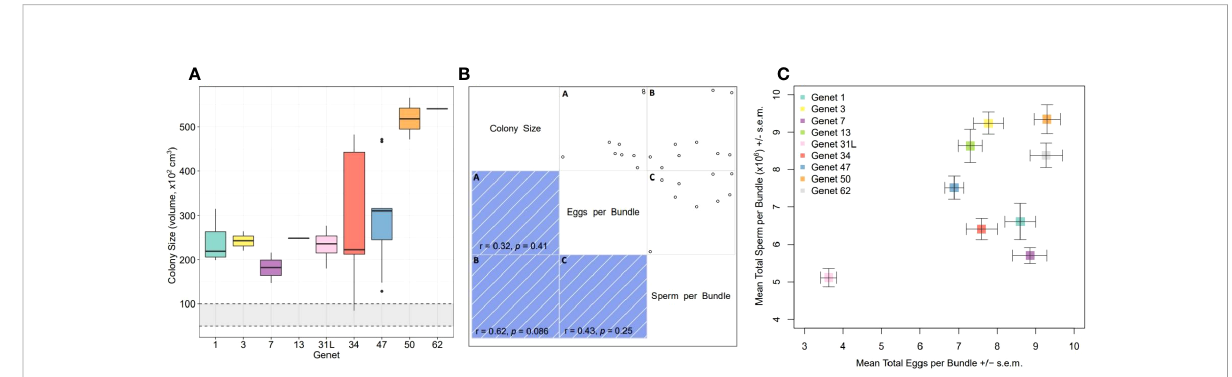
FIGURE 4 Gamete bundle fecundity analysis for nine A. cervicornis genets. (A) Colony size of the parents that the gamete bundles were collected from did not signi fi cantly differ across genets (statistics in text). The gray shaded region within the black dashed lines represents the estimated puberty size predicted for this species. Genet 31L refers to the colonies that came from a different nursery and which represent different colonies used in the fragment fecundity analysis (see methods). (B) Correlogram (correlation matrix) displaying the relationship between each pair of numeric variables as part of the gamete bundle fecundity analysis including mean colony size, mean total eggs per bundle, and mean total sperm per bundle. Scatterplots for each pair of variables is mirrored by visualization of the correlation coef fi cient including the direction (color) and strength of the association (color intensity). Blue indicates a positive association/correlation; color intensity is proportional to the correlation coef fi cient where darker hues represent stronger associations and vice versa. For each pair of variables, we calculated rank-based correlation coef fi cients using Spearman ’ s rho (r). The signi fi cance of the correlation is indicated by the p-value. All associations were positive, although none signi fi cantly so. (C) Mean total number of eggs per bundle (± s.e.m.) and mean total number of sperm per bundle (± s.e.m.) signi fi cantly differed across genets (statistics in